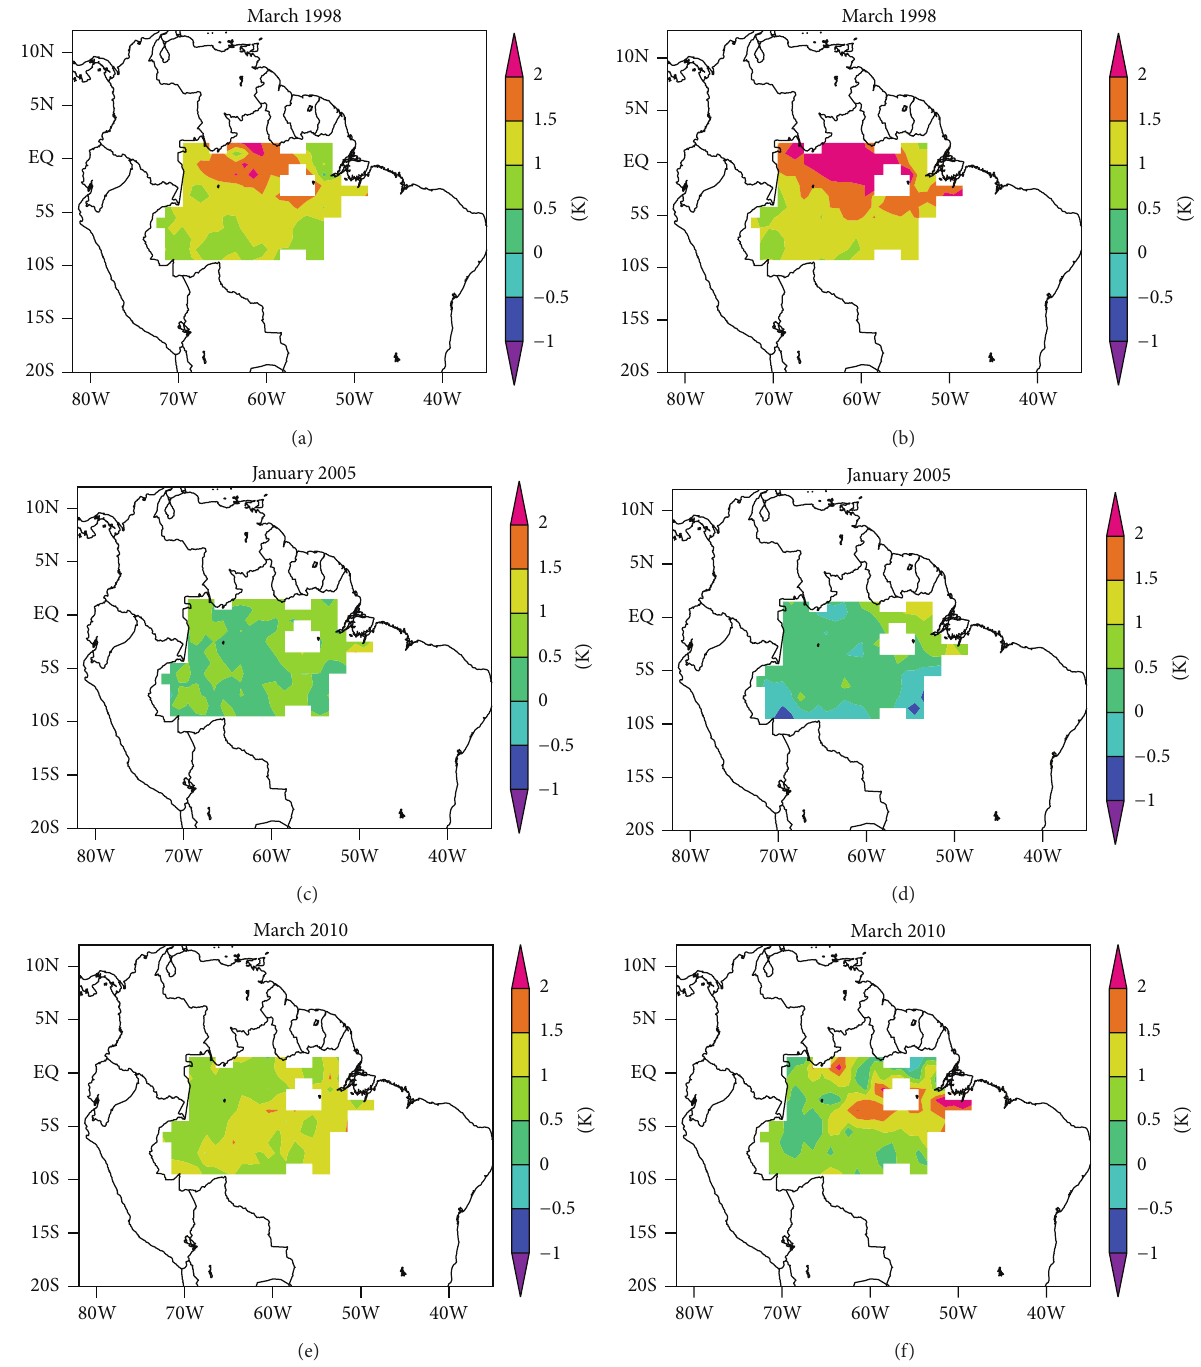
Figure 3: Spatial distribution of the remotely sensed LST anomalies over Amazon rainforests during three drought events in March 1998, January 2005, and March 2010. Left panels (a, c, and e) are for 6 a.m. and right panels (b, d, and f) are for 6